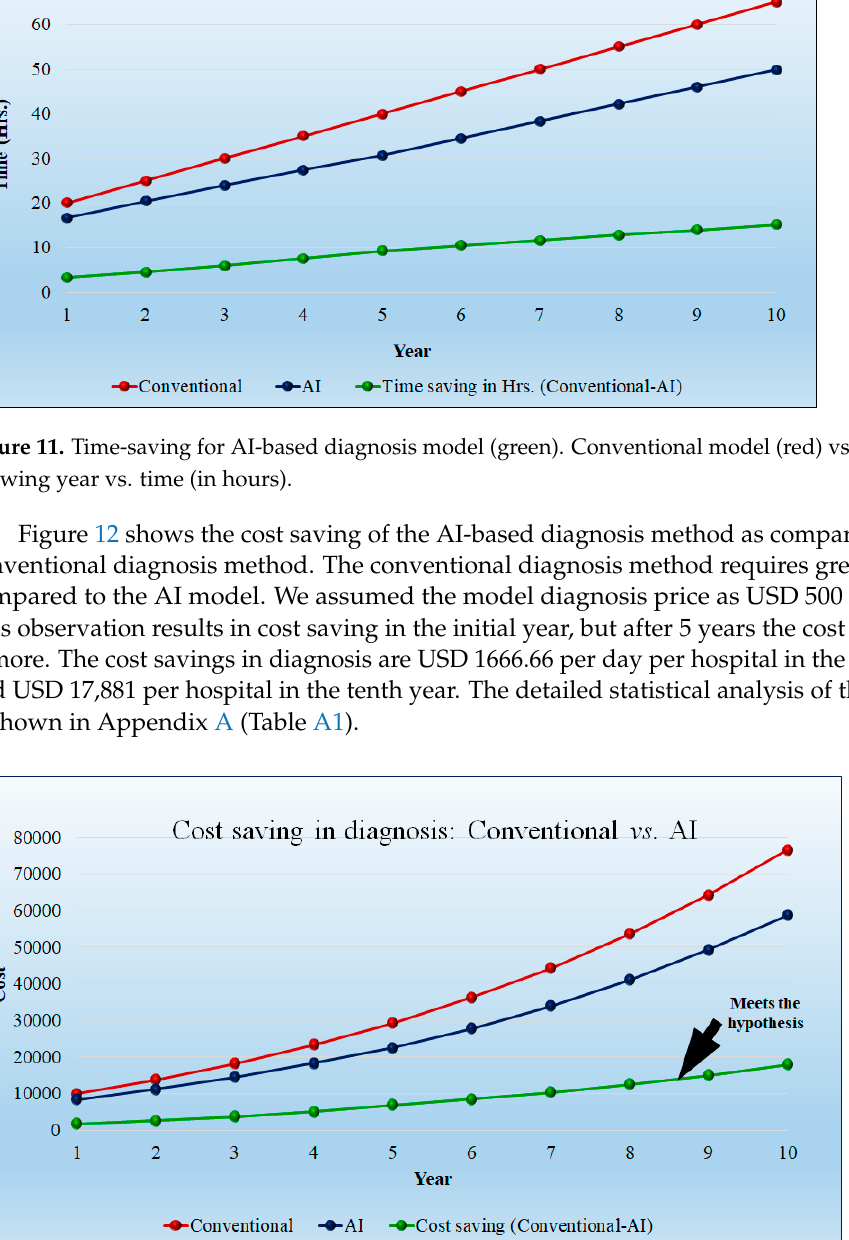
Figure 10. Patients per day per hospital for diagnosis.